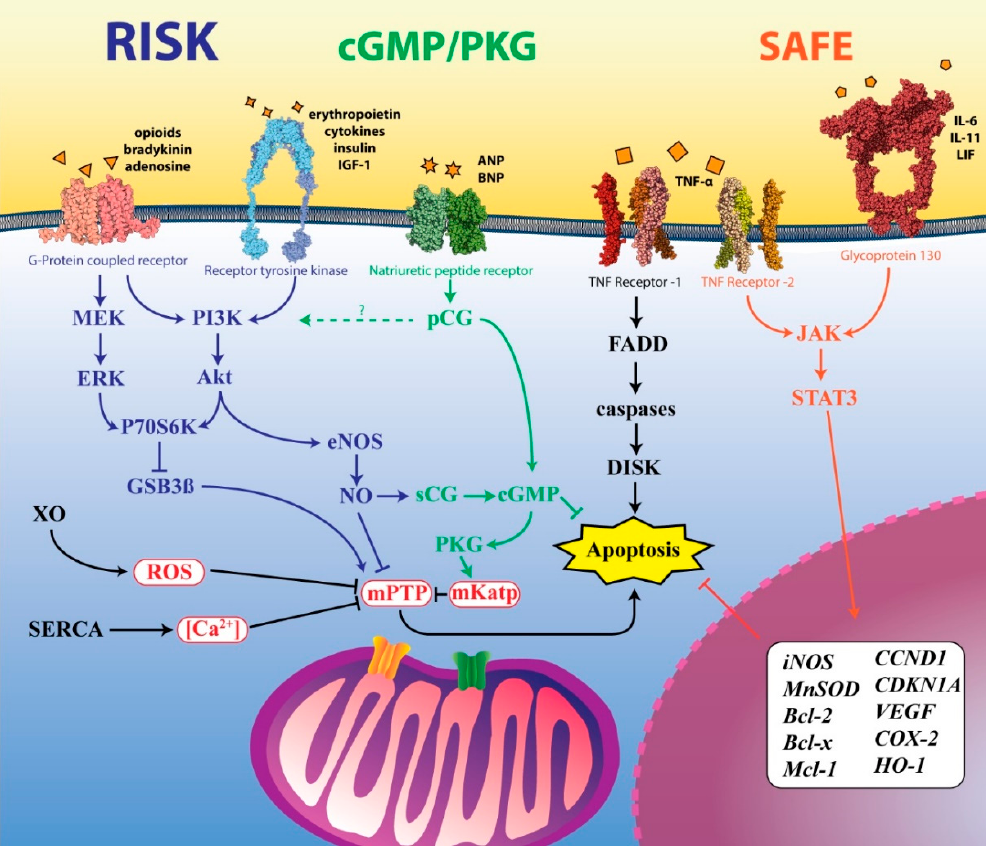
Figure 2. Simplified overview of the signaling pathways in the target cells presented in this review that are relevant for the development of a pharmacological therapy rationale. Systemic modulators were excluded from the figure. The RISK pathway (in green) is commonly activated via G-protein coupled receptors by opioids, bradykinin, and adenosine or the receptor tyrosine kinase, by erythropoietin, cytokines, insulin or insulin-like growth factor-1. The cGMP/PKG pathway (in green) receives external stimuli through the activation of the natriuretic peptide receptor, by natriuretic peptides A and B (ANP, BNP). The SAFE pathway is engaged via the glycoprotein 130 receptor or TNF- α receptor type 2 by IL-6, IL-11, leukemia inhibitory factor (LIF) or TNF-a. A fourth pathway, the TNF- α receptor type-1 is the only of deleterious character depicted in this figure. The xanthine-oxidase (XO) and sarco/endoplasmic reticulum Ca 2+ -ATPase (SERCA) pathways are shown only in order to highlight their targets. Pointed arrows mean stimulation, blunt arrows mean inhibition.